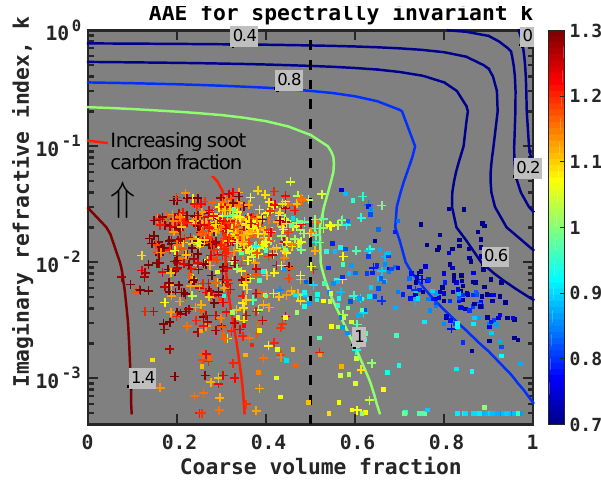
Figure 3. Contours represent AAE (440–870) for bimodal log- normal distributions with n = 1 . 49, R fin = 0 . 12µm, σ fin = 0 . 38, R crs = 3 . 2µm, σ crs = 0 . 75. Data are AAE (440–870) at all AERONET sites of Table 1, filtered for a maximum spectral vari- ability in k(λ) of 10% with respect to the mean retrieved k . Biomass burning sites are “ + ” symbols, dust sites are squares. Only 5% of the particles dominated by the fine mode indicate AAE < 1, but 90% of the particles dominated by the coarse mode indicate AAE <